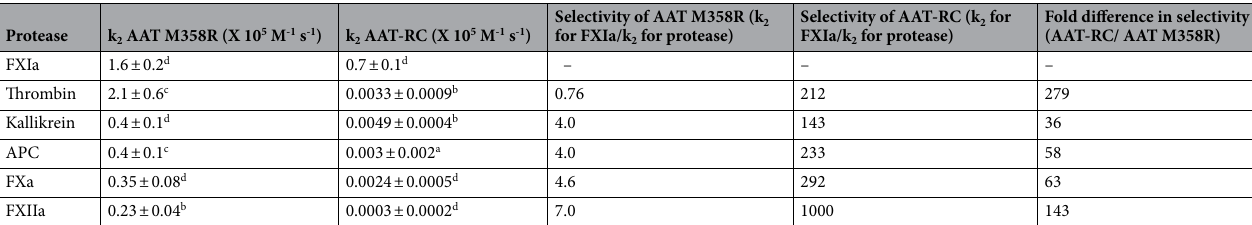
Table 3. Kinetic parameters for AAT-RC and AAT M358R with various proteases. The mean of 4 a , 7 b , 8 c , or 9 d determinations ± one standard deviation is shown, for kinetic parameters for AAT-RC and AAT M358R with various